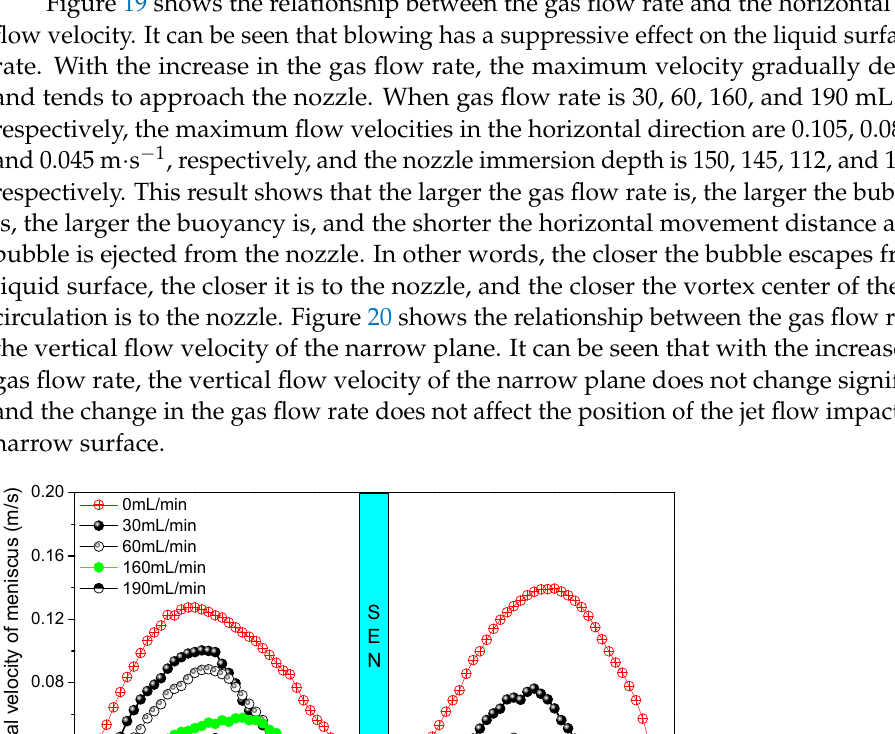
Figure 18. Schematic diagram of the output position of the liquid surface and the narrow surface.